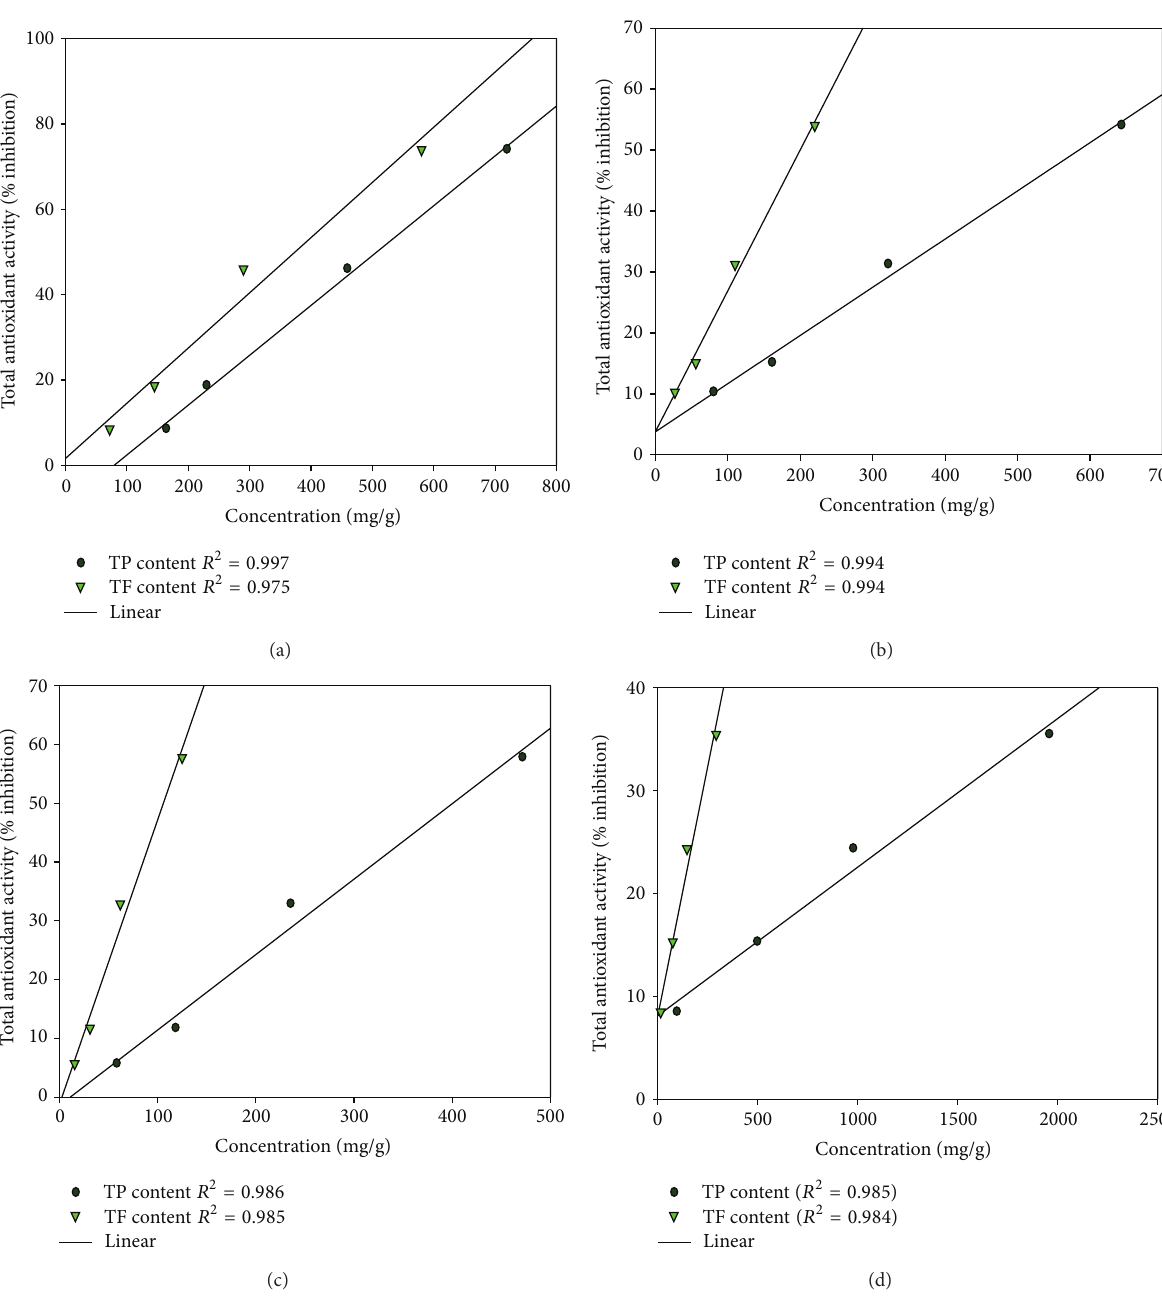
activities are quite correlated with their polyphenolic contents and reducing power. Among both plant parts, namely, aerial which is possibly due to its higher polyphenolic